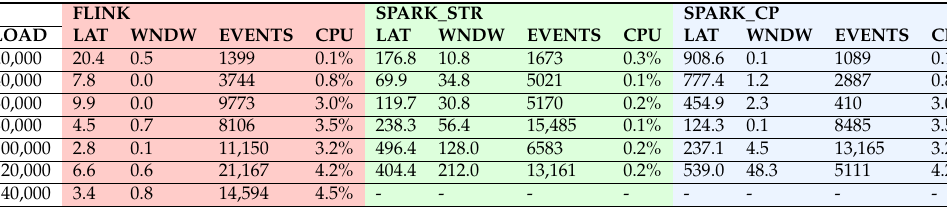
Table 2. Standard deviations per load